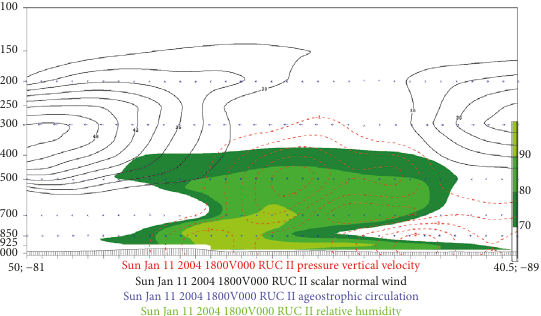
(a) 0-h RUC forecast cross-section of normal isotachs (solid black ≥ 30ms −1 [60kt]), relative humidity (green shading ≥ 70 % ), omega (dashed red negative, 𝜇 bs −1 ), and ageostrophic circulation (blue vectors), valid at 1800 UTC 11 January 2004